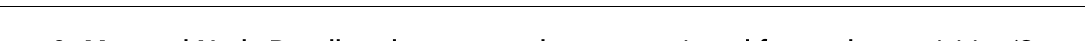
Figure 8. Montreal Node Decelles, the street and spaces equipped for outdoor activities (Source: Ville de Montréal)